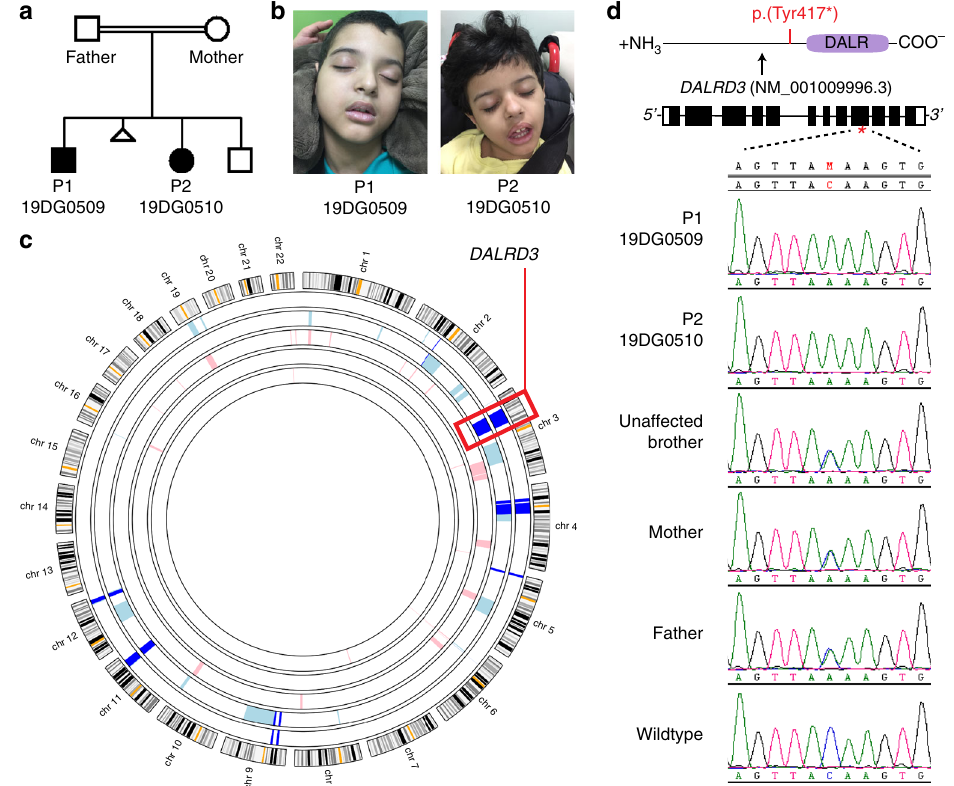
Fig. 6 Identi fi cation of a DALRD3 variant linked to developmental delay and epileptic encephalopathy. a Pedigree of the family harboring a nonsense mutation in the DALRD3 gene. b Patients 1 and 2 (P1 and P2) containing the homozygous DALRD3 mutation. c Agile MultiIdeogram output of autozygosity analysis of the study family as a series of block arcs with the two affected individuals represented by the outer two arcs. Autozygous regions from affected individuals are marked as pale blue, those from unaffected individuals as pink, and those homozygous in all affected individuals as dark blue. d Sanger sequencing chromatograms of the indicated individuals from the family in this study along with a wildtype, control